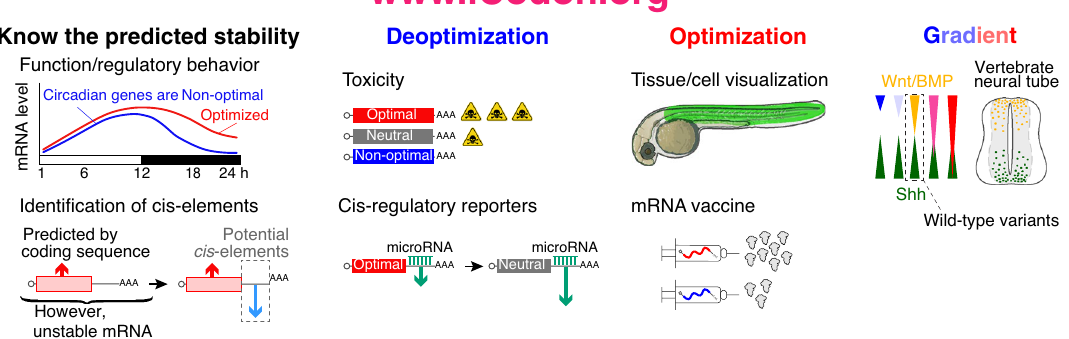
Figure 7. iCodon potential applications. iCodon can be used to uncover gene expression patters from the coding sequence; or to identify cis-regulatory elements. iCodon can be used to design sequences with neutral mRNA stability, these sequences will be more responsive to other regulatory elements (i.e., miR-430). Exogenous genes that are wanted to be expressed in a vertebrate model organism could result toxic for the cell; by designing coding sequences with a decreased expression, the toxicity level can be reduced. Tissue/cell visualization: fluorescent proteins found in another organism can be optimized for expression in vertebrate species. Injected mRNA (zebrafish embryos) or mRNA vaccine design can be codon optimized to increase the mRNA stability and expression. Expression gradient: iCodon has the potential to design a wide variety of coding sequences, which will show different gene expression